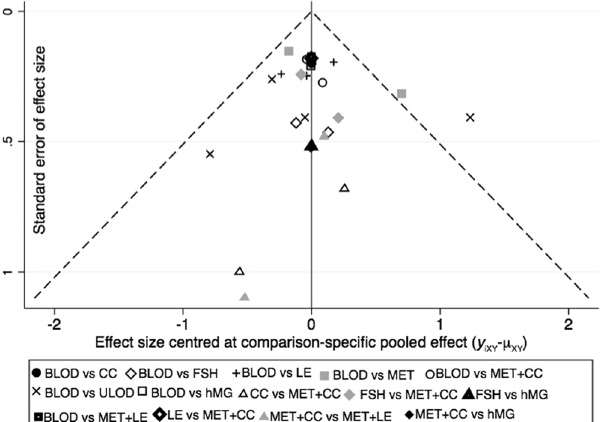
Figure 3. Funnel plot on pregnancy outcomes. CC: clomiphene citrate, MET: metformin, LE: letrozole, FSH: follicle-stimulating hormone, hMG: human menopausal gonadotropin, MET + CC: metformin combined with clomiphene citrate, MET + LE: metformin combined with letrozole, ULOD: unilateral laparoscopic ovarian drilling and BLOD: bilateral laparoscopic ovarian